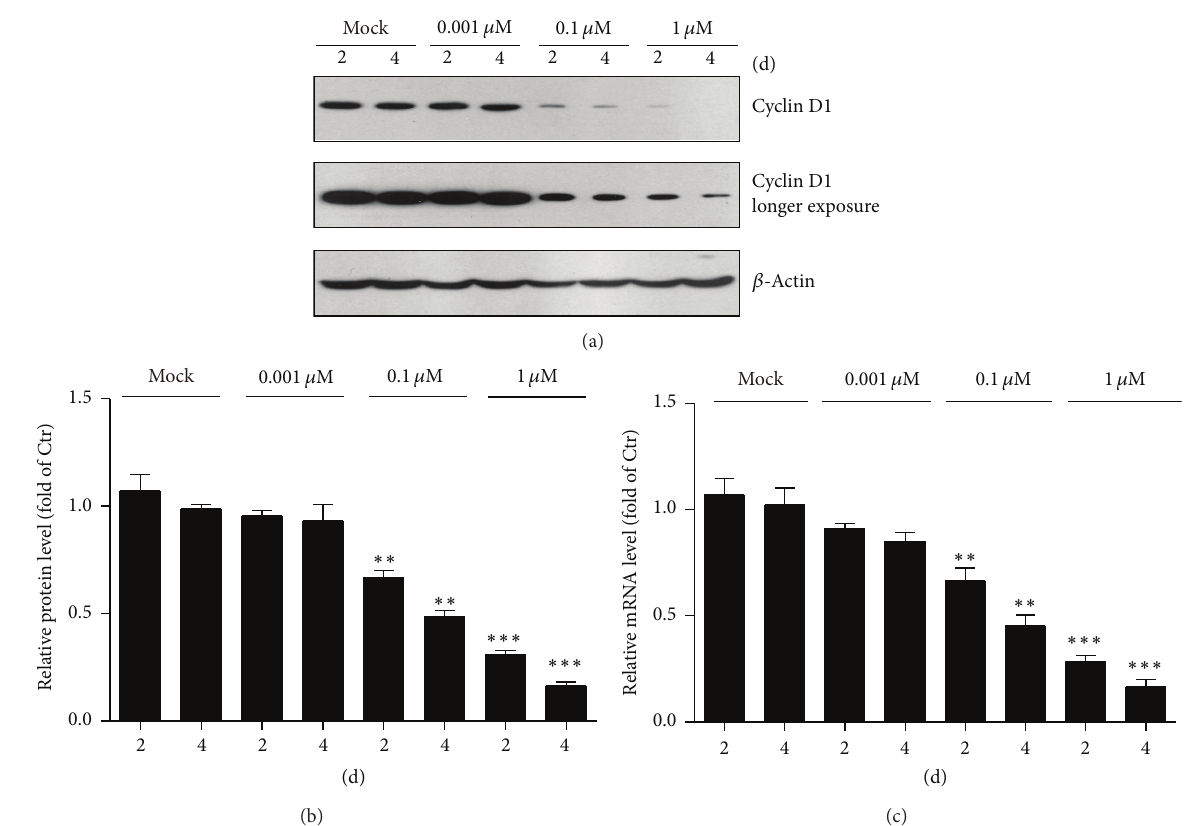
Figure 3: Thapsigargin inhibits cyclin D1 expression in MH7A cells. ((a)-(b)) Western blots and histograms showing that the cyclin D1 protein levels decreased in MH7A cells by thapsigargin treatment. Results are averages of three independent experiments. Data represent mean ± SEM. ∗∗ 𝑃 < 0.01 and ∗∗∗ 𝑃 < 0.001 . (c) Real-time PCR results showing that the cyclin D1 mRNA levels decreased in MH7A cells by thapsigargin treatment. Results are averages of three independent experiments. Data represent mean ± SEM. ∗∗ 𝑃 < 0.01 and ∗∗∗ 𝑃 < 0.001 .